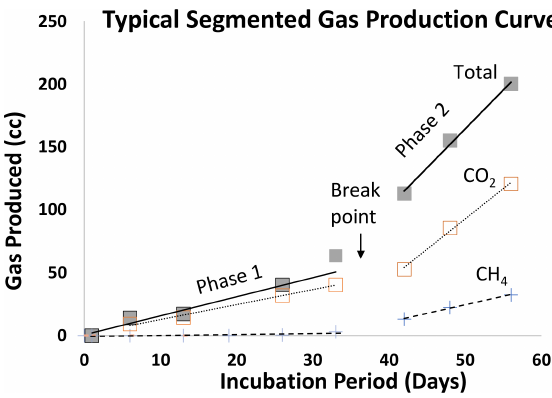
Figure 1. Typical gas production in saturated soils amended with organic matter (all experiments). Gases were best modeled using a segmented linear function. After a breakpoint the average total gas production increased by a factor of ∼ 5, whereas there is a sharp ( (cid:29) 5 × ) increase in methane production. Data presented are from the manure-amended (1 × ) trials in sandy clay loam. Note that hay-amended trials exhibited a typical sinusoidal pattern (shown in Figs. S2 and 3h, i, and